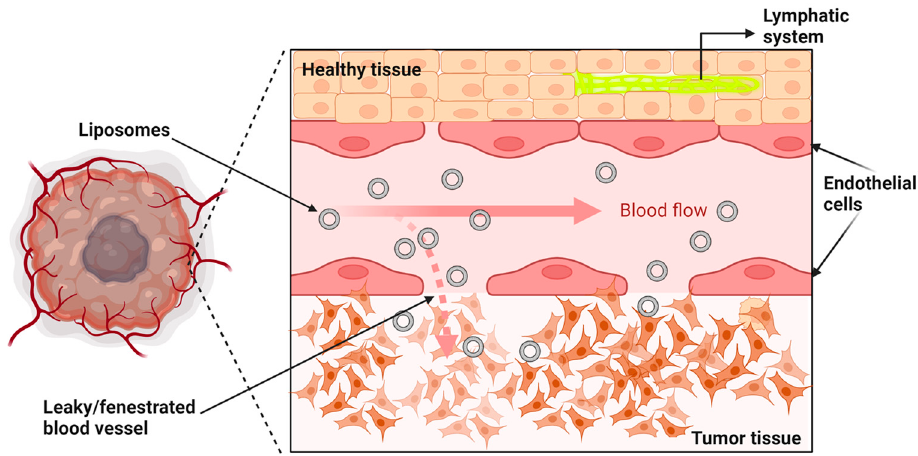
Figure 3. Tumor vasculature leakage. Tumor vasculature exhibits structural abnormalities, fenestrated blood vessels, and absence of a lymphatic system ( bottom ) compared to normal/healthy vasculature ( top ). Image was created with BioRender.com (accessed on 1 February 2023).